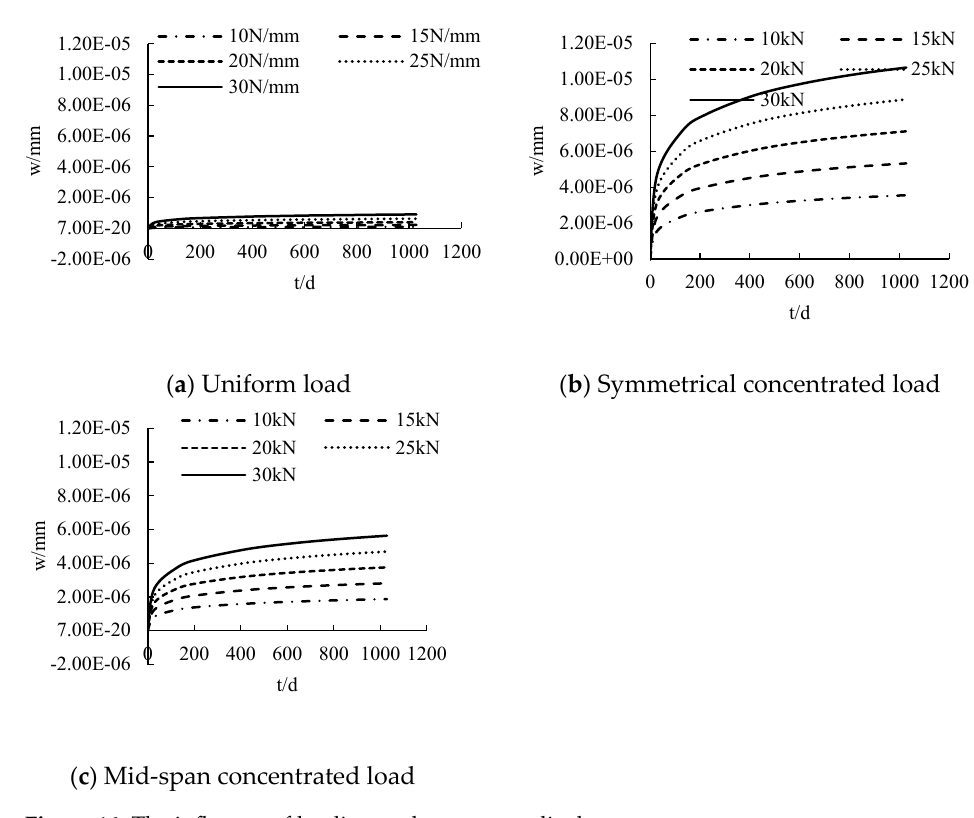
Figure 16. The influence of loading under creep on displacement.